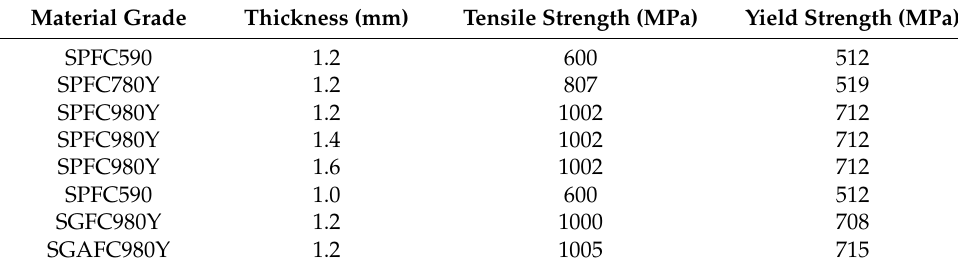
Table 1. Mechanical properties of